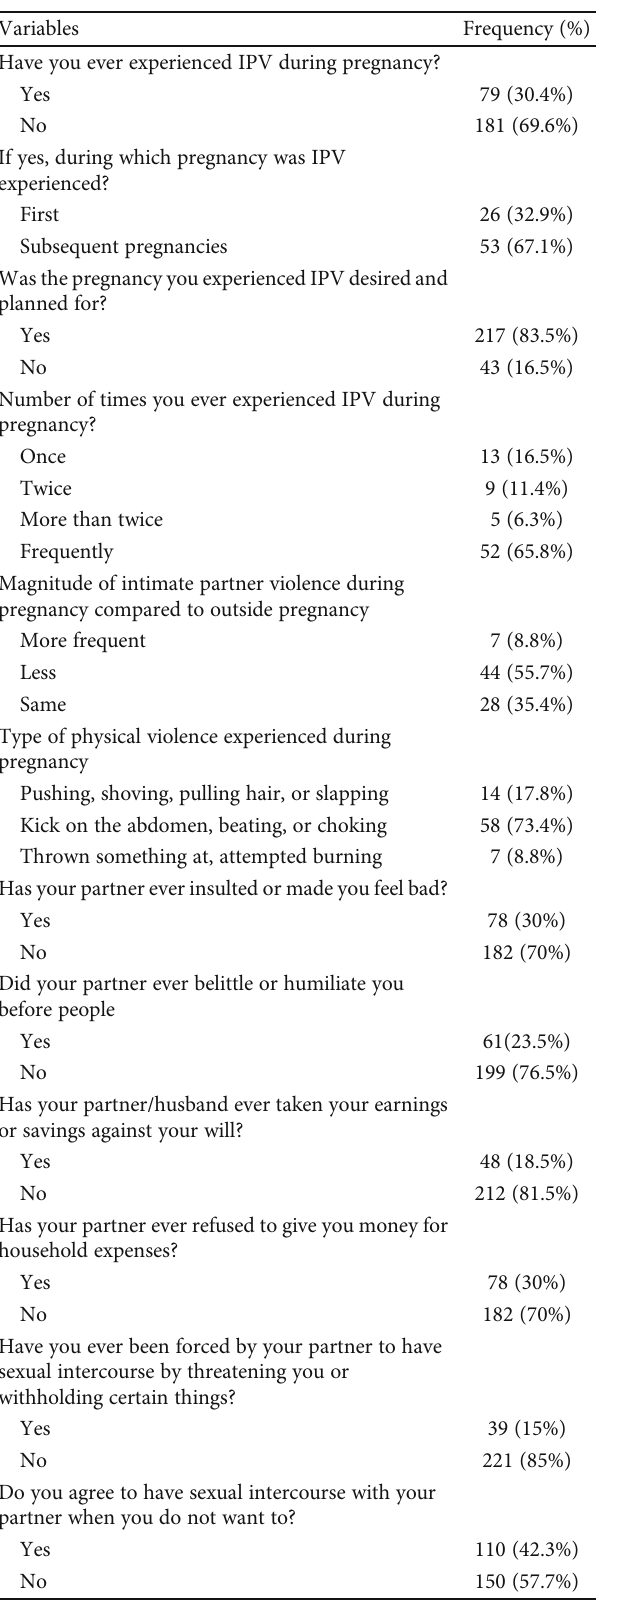
Table 4: Reactions of respondents following their experience of IPV during